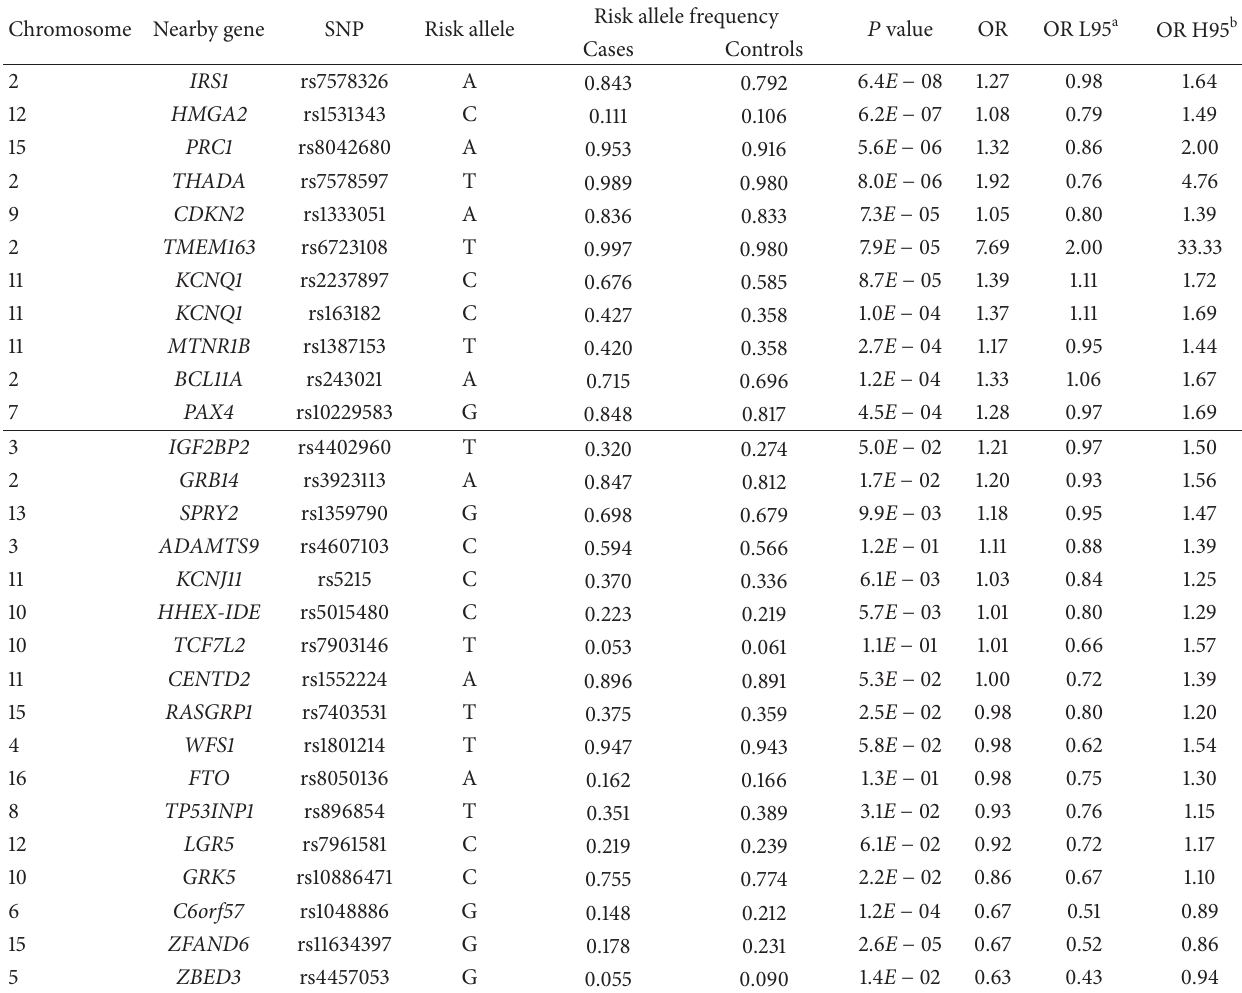
Table 2: Association of 28 SNPs tested with T2D in a Mongolian